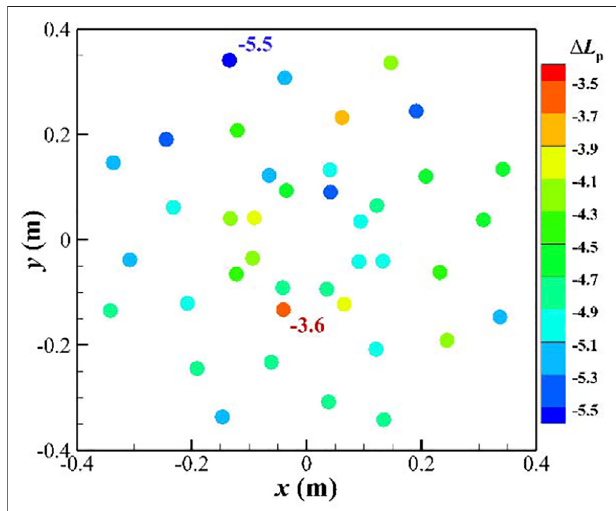
FIGURE 10 | Difference in OASPL ( fi ltered between 900 and 1,200 Hz) of the propeller at 5,100 r/min in the acoustic array.